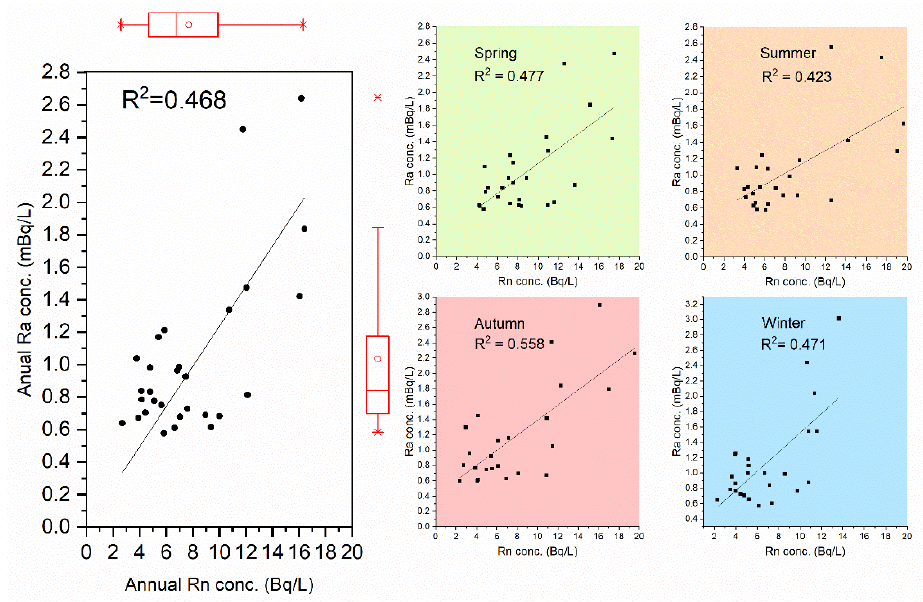
Figure 5. The correlations between the seasonal ( right ) and annual ( left ) radon and radium concentrations.